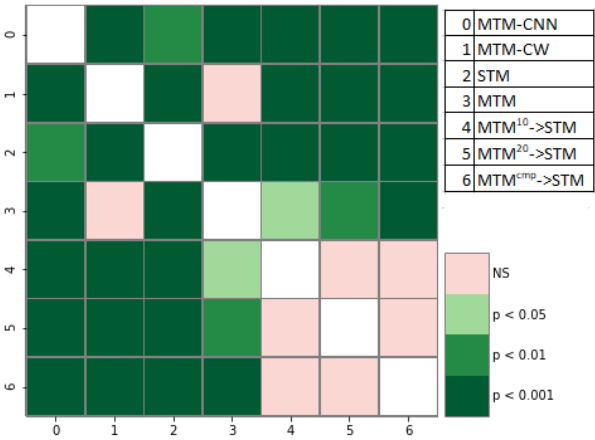
Figure 11. Post hoc Friedman test output for MTM → STM .